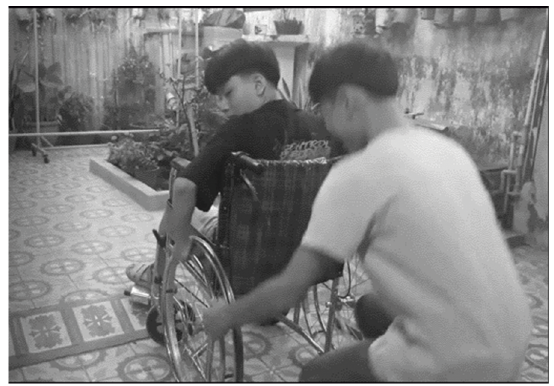
Figure 4. The member of Group 1 tries to ride up available